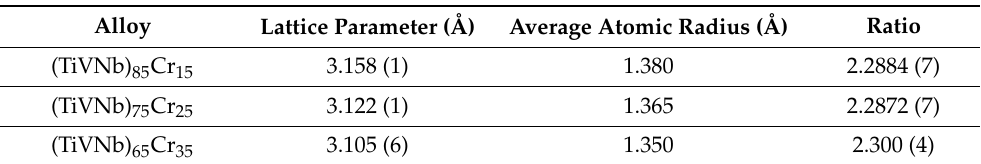
Table 2. Lattice parameter evaluated by XRD analysis for alloys with different Cr content in the as-cast condition. Nominal average atomic radius and ratio of the lattice parameter over the average radius.